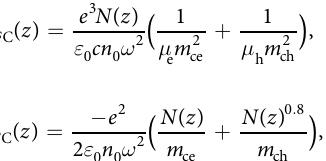
where A ( z , t ) is the slowly varying envelope of the pulse, z and t are the propagation distance and time in the frame co-moving with the group velocity v g ( z ) of the optical pulse, respectively. β n ( z ) = d n β / d ω n is the n- th order dispersion coefficient. κ ( z ) is the confinement factor of the guiding layer. c and n 0 are the speed of light in vacuum and refractive index of a-Si:H-PhWs, respectively. α FC and α l are the FCA and linear losses, which are ~2 dB/cm at 1550 nm and ~0.5 dB/cm at 2150 nm 37 . δ n FC and τ are the free-carrier induced refractive index change and the self-steepening factor. α FC and δ n FC are given by 46–48 .